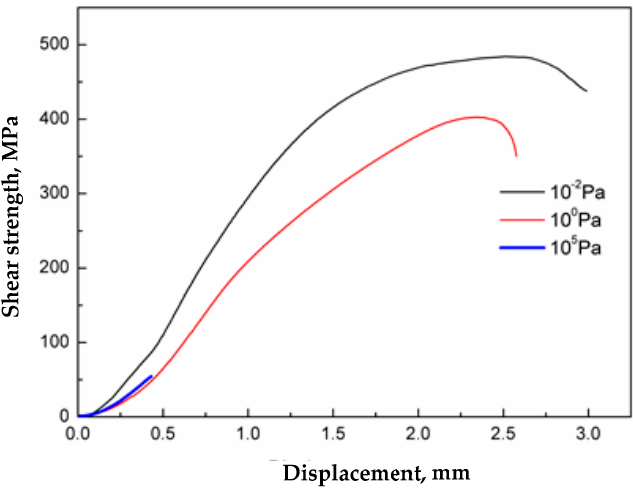
Figure 14. Shear strength-displacement curves of stainless clad steel interface at different vacuum degree.